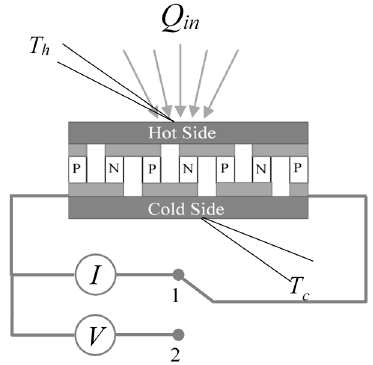
Figure 2. Diagram of the circuit used.